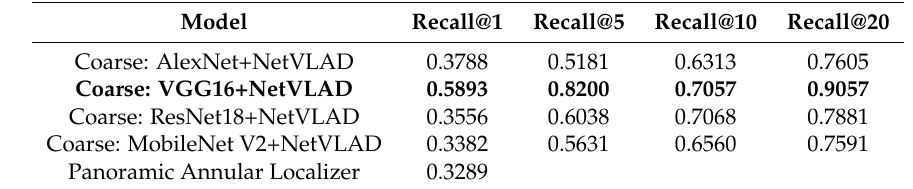
Table 5. Localization results of coarse stage on the Yuquan dataset [2]–Dusk as query, and Afternoon1 as